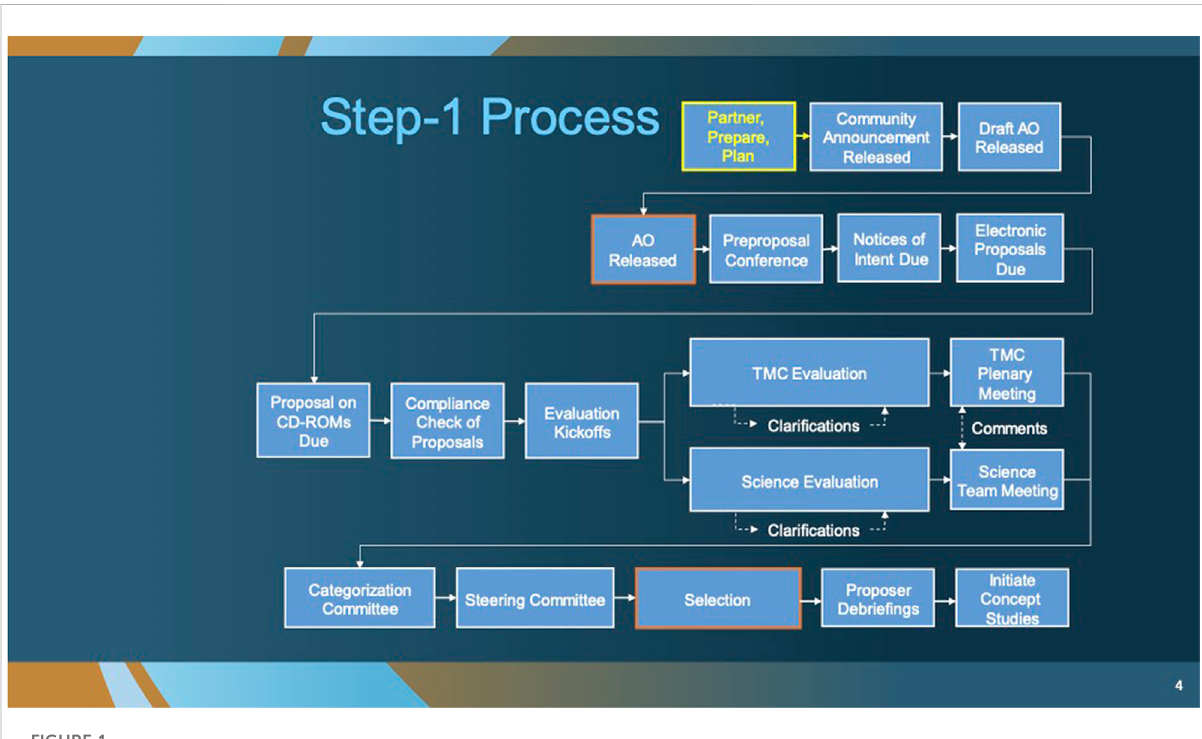
FIGURE 1 A fl owchart of the NASA evaluation process for PI lead missions. Slide taken from 2019 PI